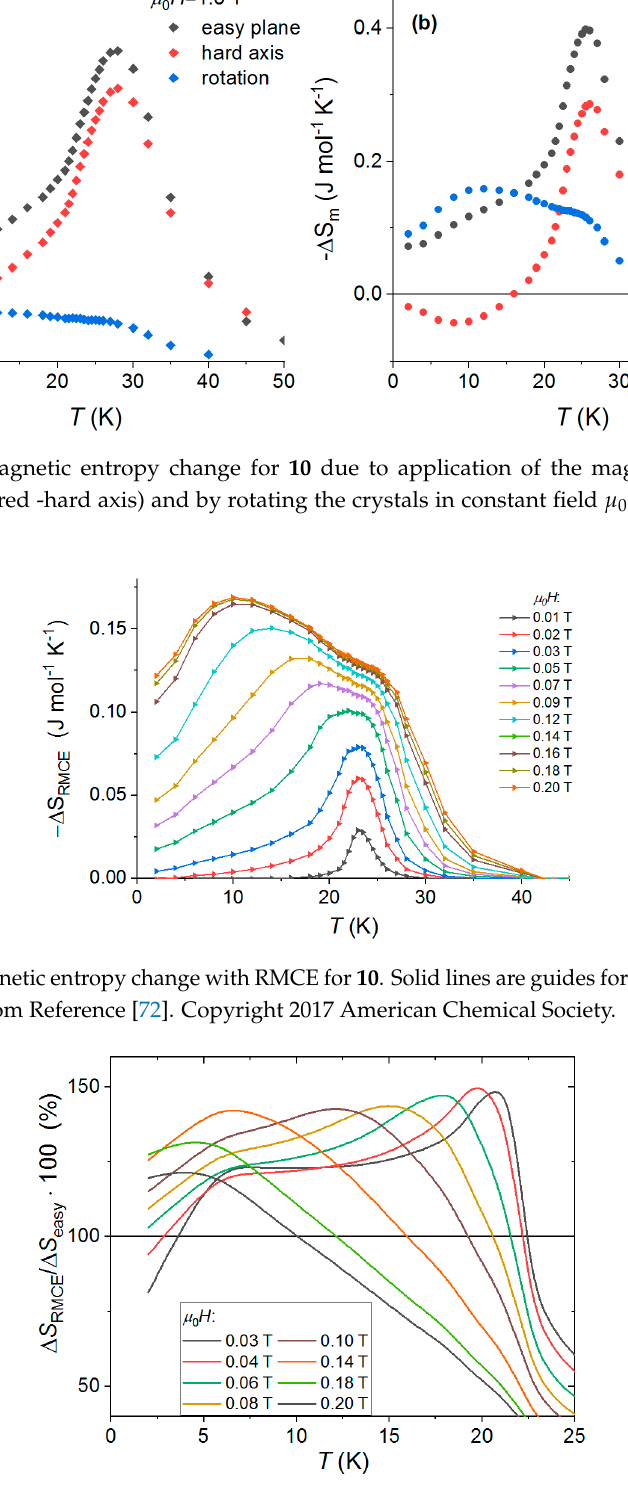
Figure 30. Temperature dependence of percentage ratio between ∆ S RMCE and ∆ S easy (easy plane) for 10 for different fields. Adapted with permission from Reference [72]. Copyright 2017 American Chemical